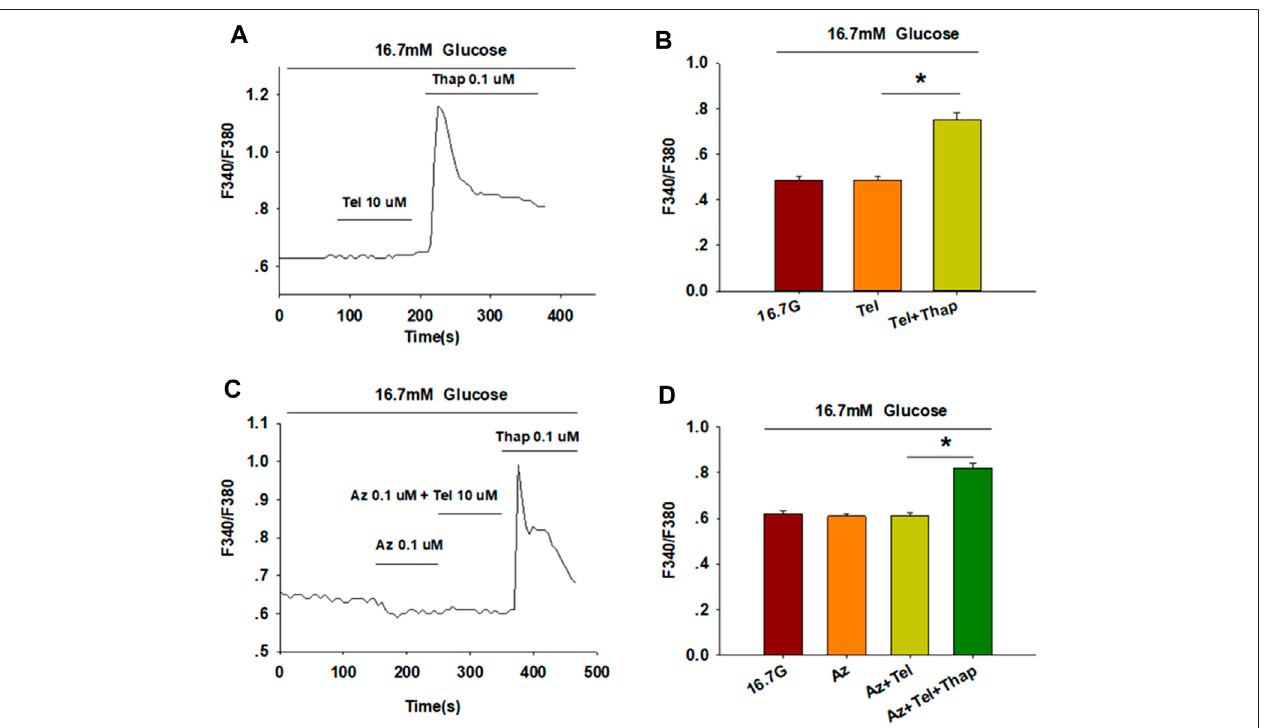
FIGURE 4 | Telmisartan enhances [Ca 2+ ] i levels through extracellular Ca 2+ in fl ux, rather than intracellular Ca 2+ stores release. (A) The trace shows the changes of [Ca 2+ ] i concentrationin β -cellstreatedwithtelmisartan (Tel,10 μ M) under16.7 mM glucose conditions inCa 2+ -free KRBH medium. (B) The averagevalue ofF340/F380 during each test in response to telmisartan (Tel, 10 μ M) in Ca 2+ -free KRB medium ( n (cid:1) 23 cells). (C) The trace shows the changes of [Ca 2+ ] i concentration in β -cells treated with telmisartan (Tel 10 μ M) under 16.7 mM glucose conditions with addition of the L-type VGCC blocker azelnidipine (Az, 0.1 μ M). (D) The mean value of F340/F380 during each test in response to telmisartan (10 μ M) with added azelnidipine (0.1 μ M). Thapsigargin (Thap, 0.1 μ M) was used as a positive control ( n (cid:1) 12 cells). The cells compared between the groups in each graph are isolated from the same animal. All results are reported as the means ± SEM. Statistical differences among three or more groups were determined by one-way ANOVA, followed by Tukey Test post hoc analysis. * p <